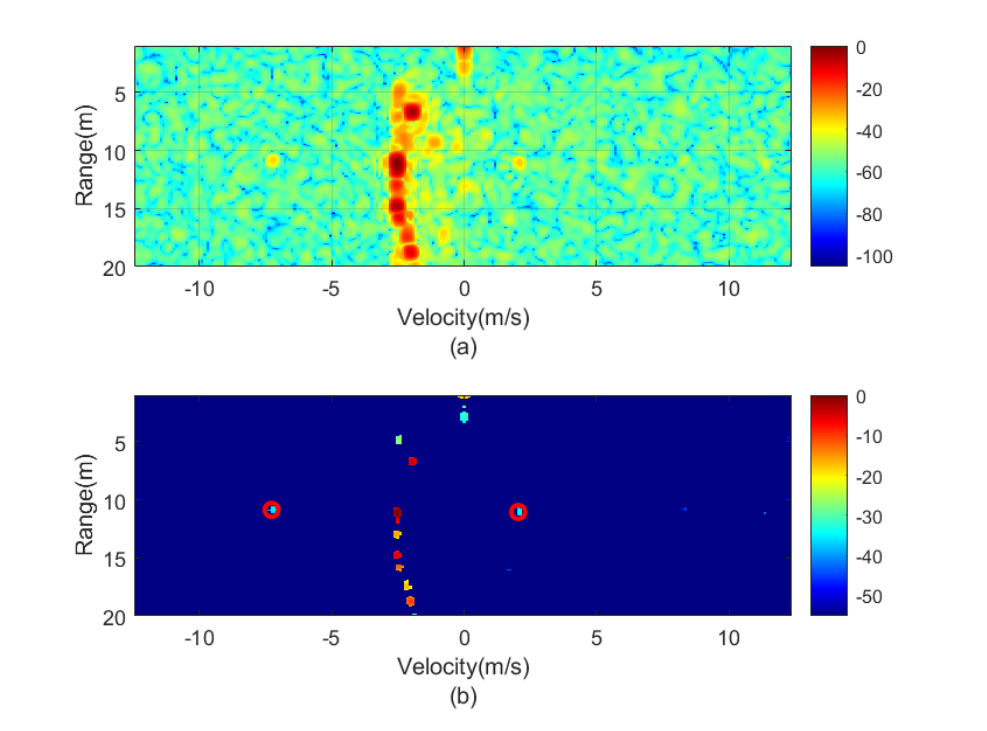
Figure 10. Measured range—Doppler map ( a ) and detection after CFAR processor ( b ) for the transponder modulated at 500 Hz.